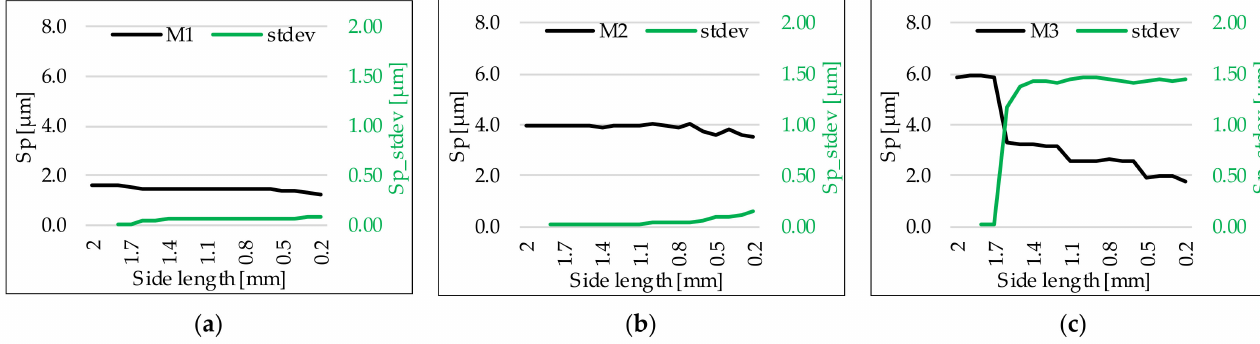
Figure 8. Sp parameters (black) and their standard deviations (green) as a function of the analyzed area (2 × 2 mm–0.2 × 0.2 mm): ( a ) M1—hard turning, f = 0.1 mm/rev; ( b ) M2—hard turning, f = 0.3 mm/rev; ( c ) M3—grinding.